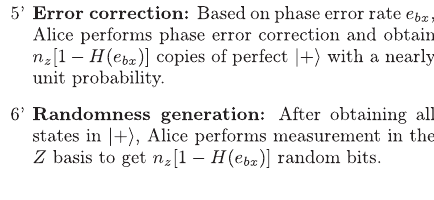
FIG. 4. An equivalent protocol of source-independent